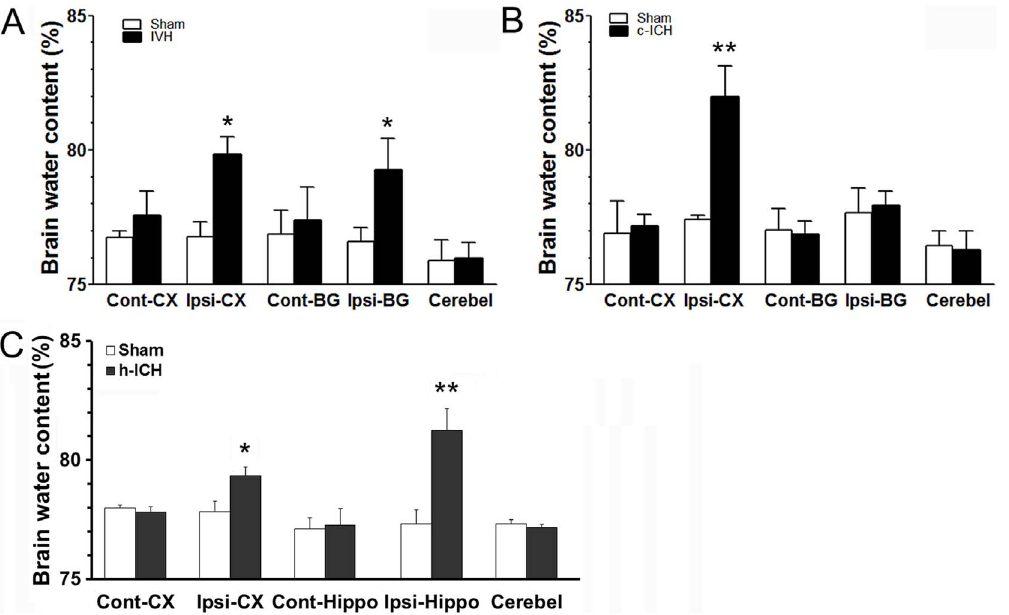
Figure 2. Brain edema is increased after intracerebral hemorrhage (ICH) in ventricle, cortex, and hippocampus. Three days after ICH, percentage brain water content was increased in the ipsilateral cortex and basal ganglia in the IVH group (n=4 mice per group, A), in the ipsilateral cortex in the c-ICH group (n=4 mice per group, B), and in the ipsilateral cortex and hippocampus in the h-ICH group (n=4 mice per group, C). Cont- CX, contralateral cortex; Ipsi-CX, ipsilateral cortex; Cont-BG, contralateral basal ganglia; Ipsi-BG, ipsilateral basal ganglia; Cont-Hippo, contralateral